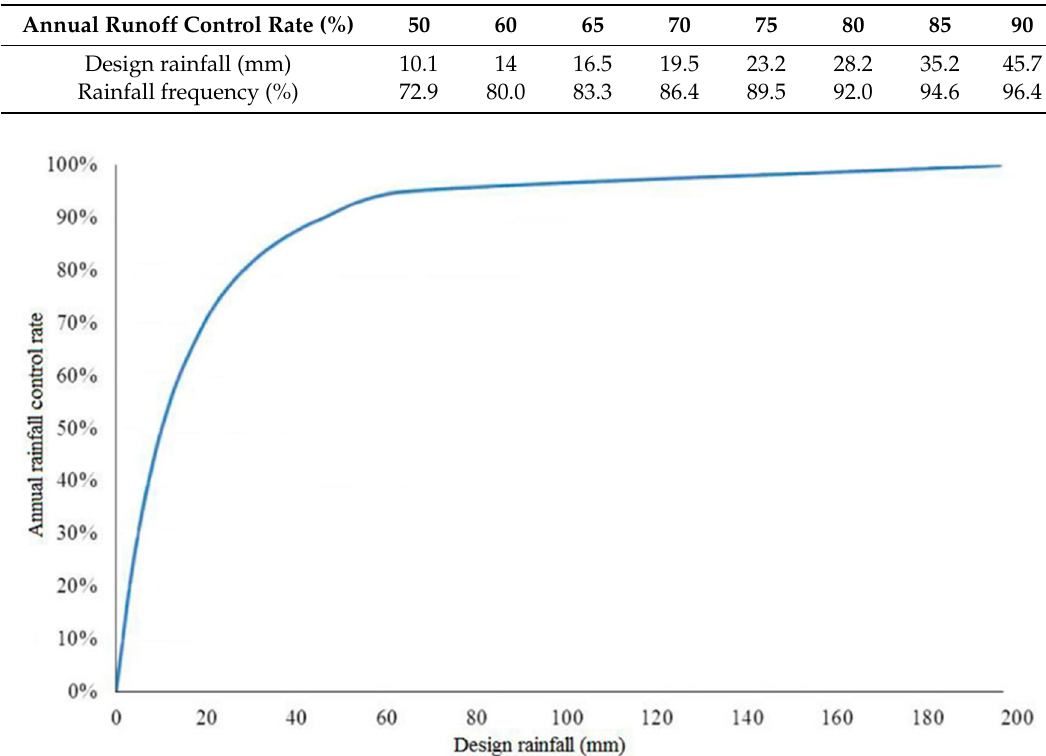
Figure 6. Corresponding relationship between the annual runoff control rate and the design rainfall.